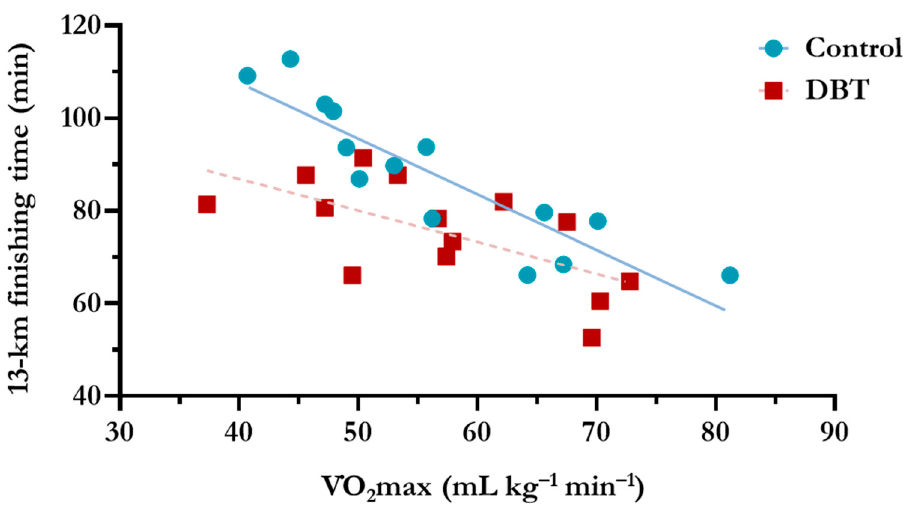
Figure 3. Relationship between VO 2 max and finish time in each group as analysed using Spearman’s correlation ( r = − 0.925, p < 0.001, slope = − 1.203 in control group; r = − 0.649, p < 0.05, slope = − 0.682 in DBT group).